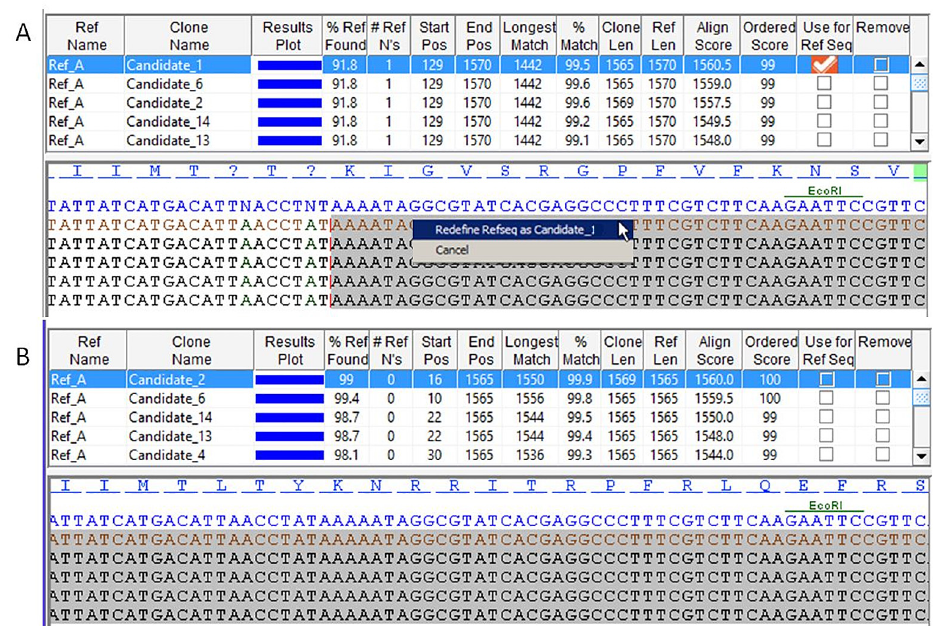
Fig 4. Change the reference sequence. Right-clicking a candidate sequence (A) results in an orange check mark in the “ Use for Ref Seq ” column. After such changes, the alignment needs to be saved and rerun, after which the selected clone sequence will become a reference sequence and the previous reference sequence will become a candidate sequence. (B) The same view as (A) with the new reference sequence now being utilized. Ambiguities are resolved and the original single-base deletion is restored resulting in correction of the reading